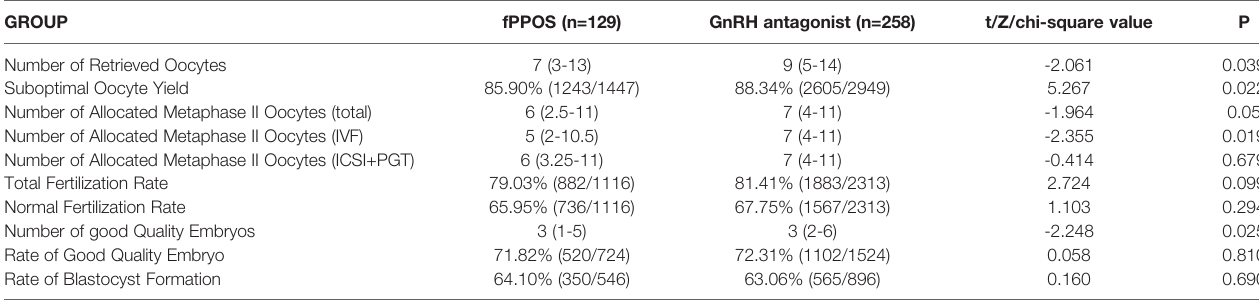
TABLE 3 | Embryo laboratory data between the two groups.